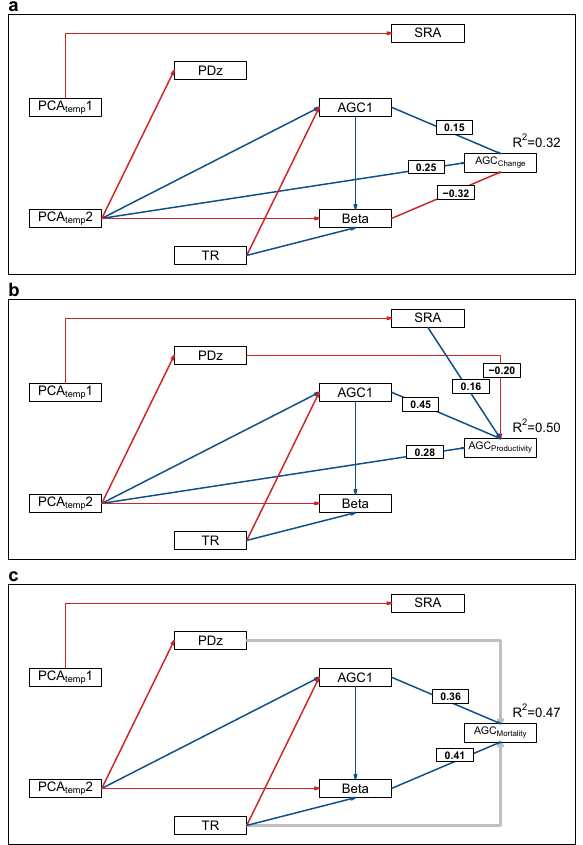
Fig. 3 Drivers of aboveground carbon dynamics in the Andes. Structural equation models (SEMs) used to evaluate the effects of climate (PCA temp 1 and PCA temp 2), initial aboveground carbon stock in each plot (AGC1; Mg C ha − 1 ), thermophilization rate (TR; °C y − 1 ), symbiotic root associations (SRA = ln(AM/EcM)), the standardized effect size of the phylogenetic diversity (PDz), and the size-dependent probability of mortality ( β ) on aboveground carbon dynamics. AGC change = aboveground carbon net change (Mg C ha − 1 y − 1 ) ( a ). AGC productivity = aboveground carbon productivity (Mg C ha − 1 y − 1 ) ( b ). AGC mortality = aboveground carbon mortality (Mg C ha − 1 y − 1 ) ( c ). Red arrows indicate negative relationships and black arrows indicate positive relationships. Grey arrows represent signi fi cant ( P ≤ 0.05) relationships in the IT models (Supplementary Table 7), but not in the SEM models. The values over the arrows are the associated linear coef fi cients of the explanatory variables found to be signi fi cant. R 2 = Coef fi cient of determination of the overall model.